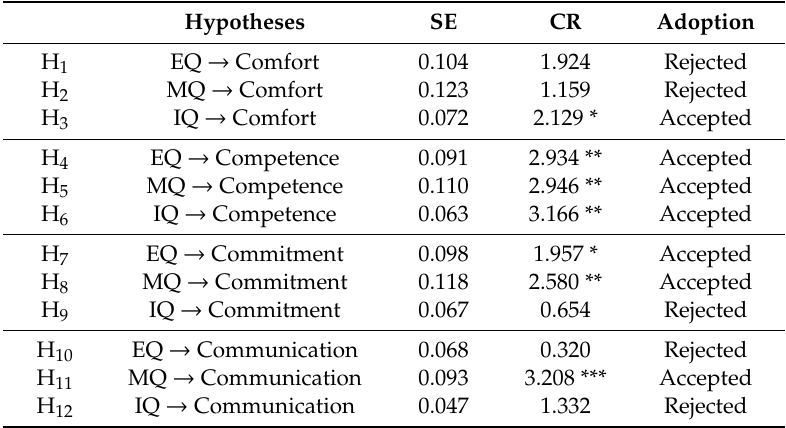
Table 6. Results of the hypothesis